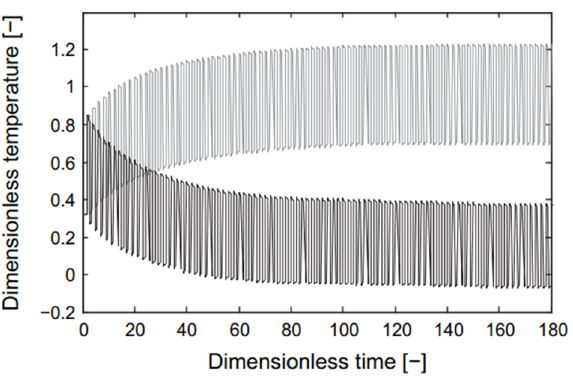
Figure 17. Dimensionless temperature evolutions as function of the dimensionless time for AMRR [63]. One year later, the same authors coupled this model to a 2-D magnetic model [98]. This new model also included three sub-models [68,99,100]. The model took into account Tušek et al. (2011) [65] achieved a 1-D model to study an AMRR reciprocating oper- the variation of the internal magnetic field, the MCE, and the heat transfer between the fluid and the solid. This coupled magneto-thermal model has been validated with experimental measurements (Figure 20).